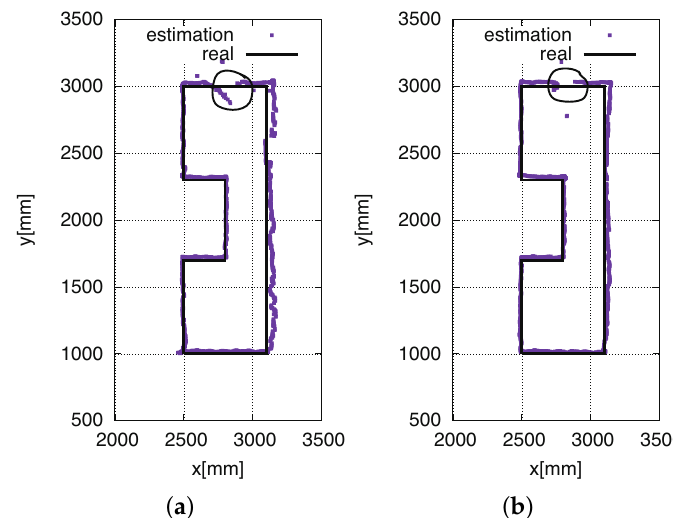
Figure 14. Real-time self-localization trajectory obtained using ( a ) the eight HF-band RFID reader system using the conventional Gaussian model and ( b ) the eight HF-band RFID reader system using the proposed likelihood model. The density of the ID tags was 100 tags/m 2 , and the robot speed was 100 mm/s.